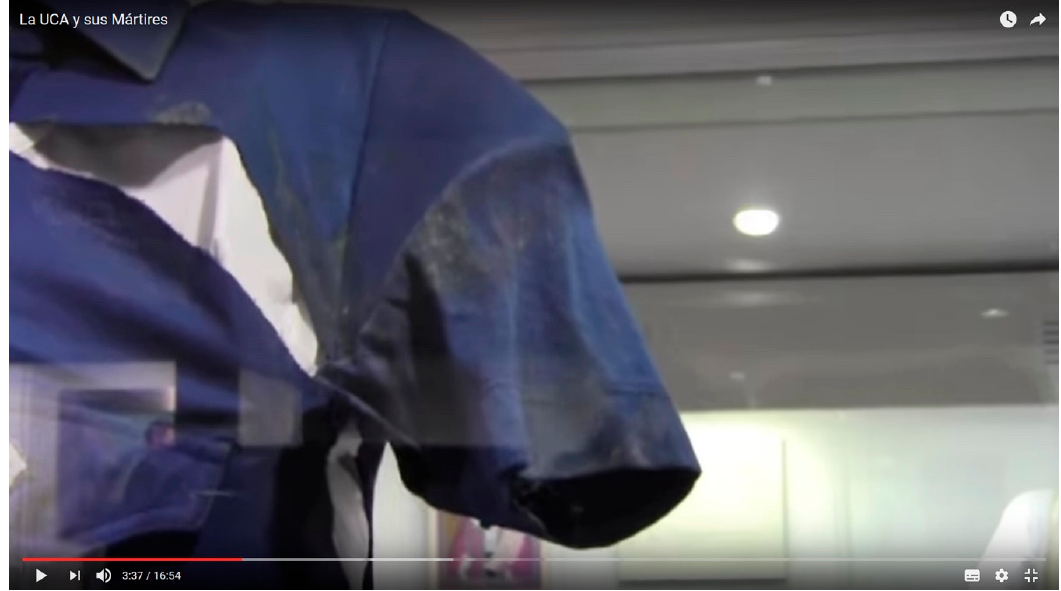
Figure 5. Ripped shirt belonging to Ignacio Martin Baró at display in the UCA museum. Screenshoot from Ochoa (2011).